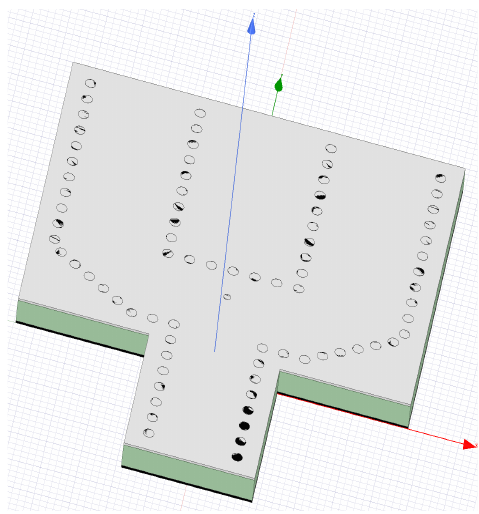
FIGURE1. The Two-way SIW power divider structure in the H plane.